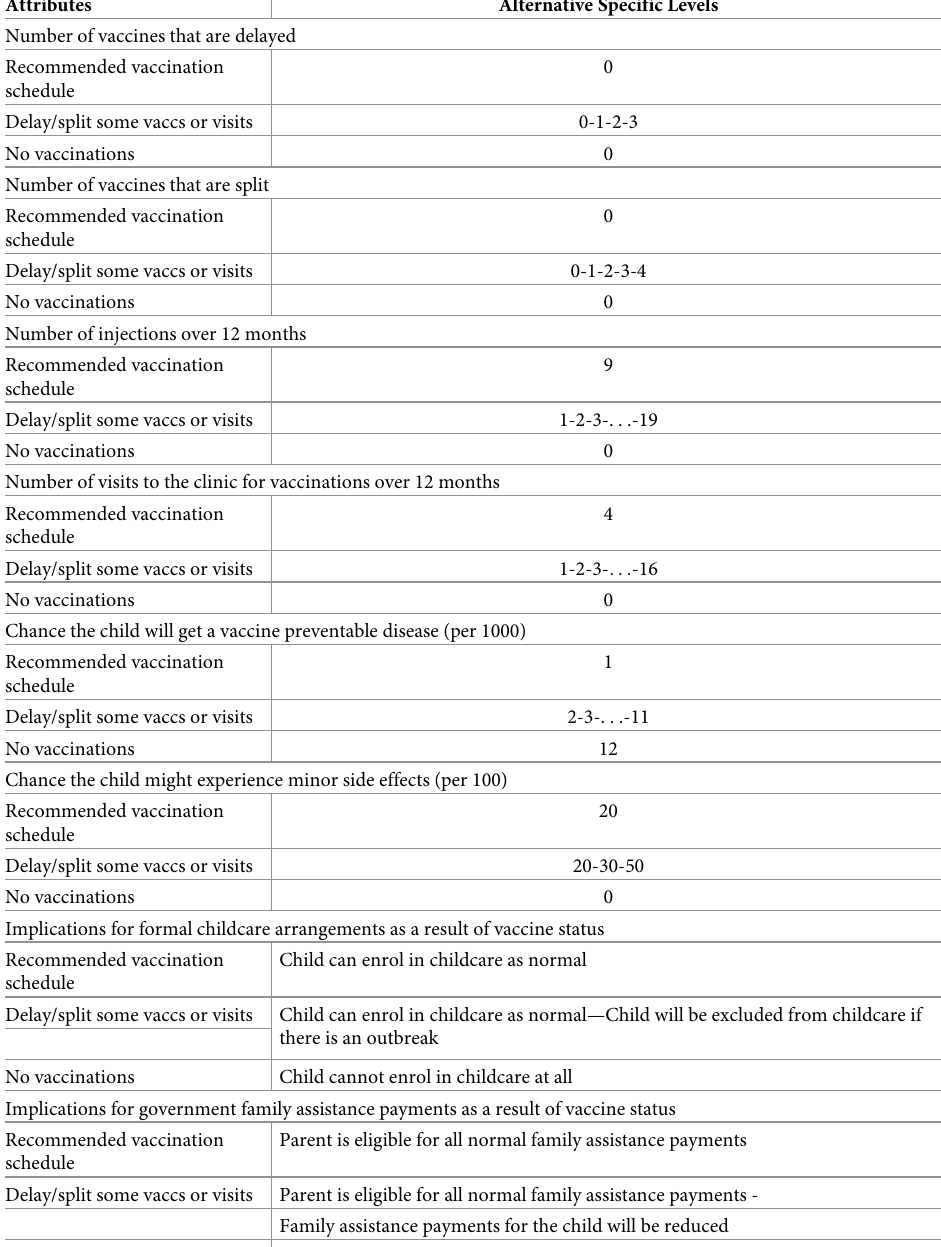
Table 1. Attributes and alternative specific levels for childhood vaccination in Australia.